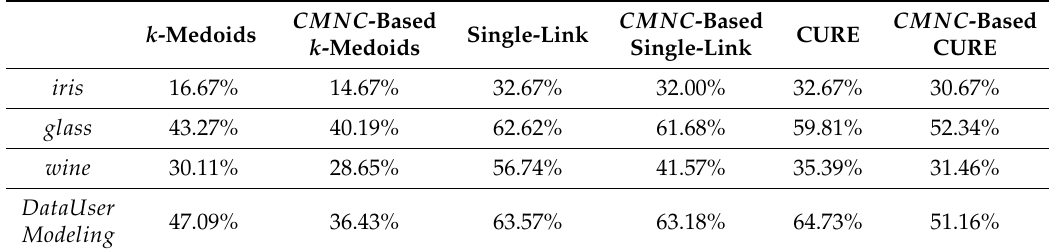
Table 1. Clustering Error (CE) results of the tested methods.